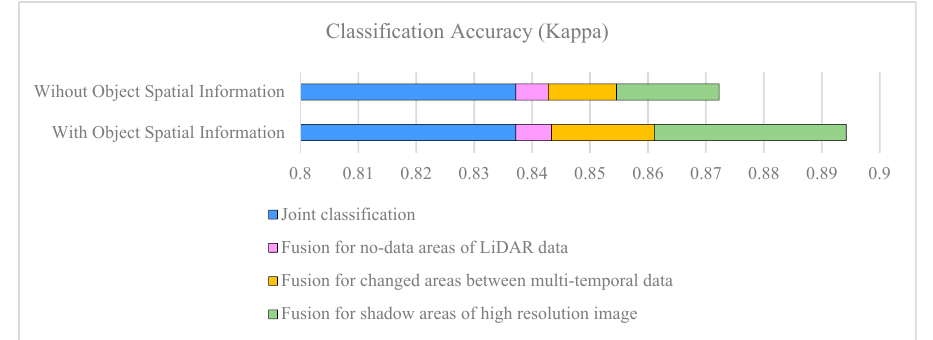
Figure 17. Classification accuracies with different fusion approaches. Different colors indicate the increased accuracies after each step of object-based post-classification fusion.